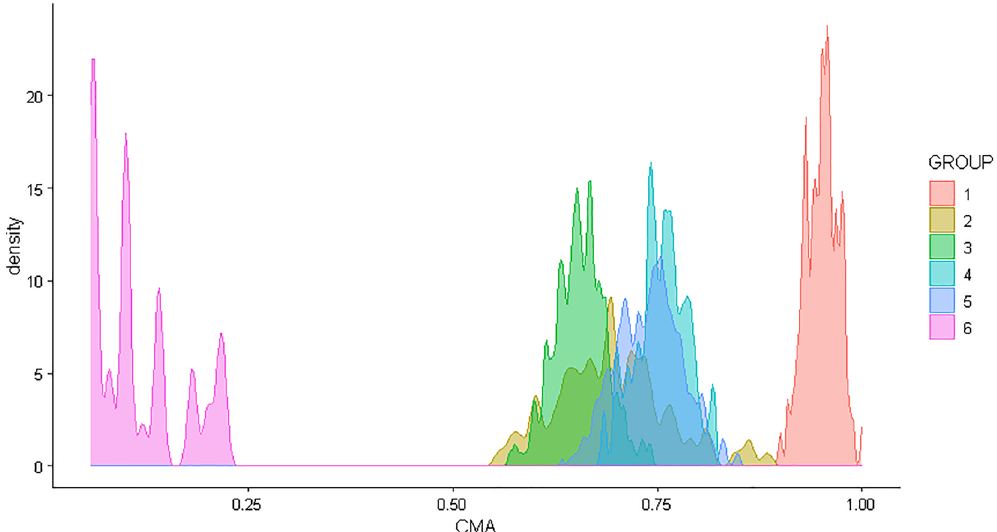
Figure 2. Density plot of adherence for the six groups mimicking real-world treatment patterns for which adherence was 1) high (95%), 2) medium (50–90%), 3) gradually declining over time, or 4) intermittent (with a change between high and low adherence at regular intervals), 5) Partial drop-off (with high adherence initially and partial drop-off after some time), and 6) non-persistence (with one or two refills after the initial fill and no refills afterward) (see also Allemann and colleagues 16 ). CMA = Continuous multiple interval measures of medication